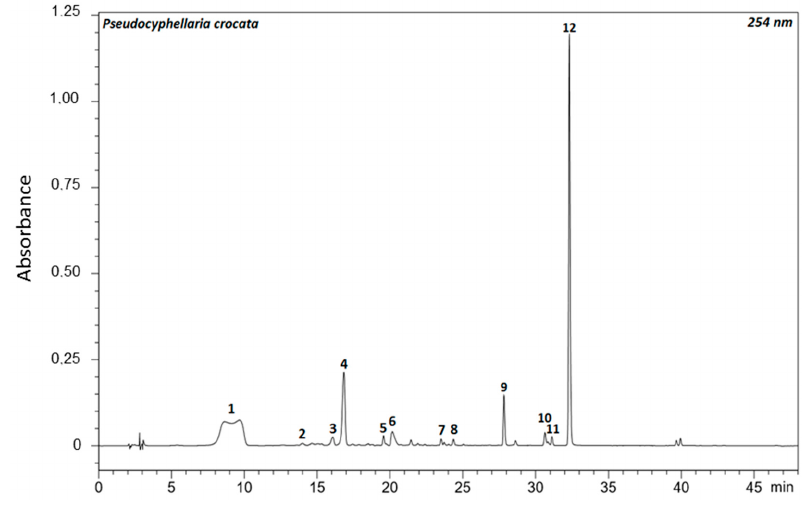
Figure 2. PDA chromatogram at 254 nm of P. crocata acetone extract. Identified compounds are ( 1 ) constictic